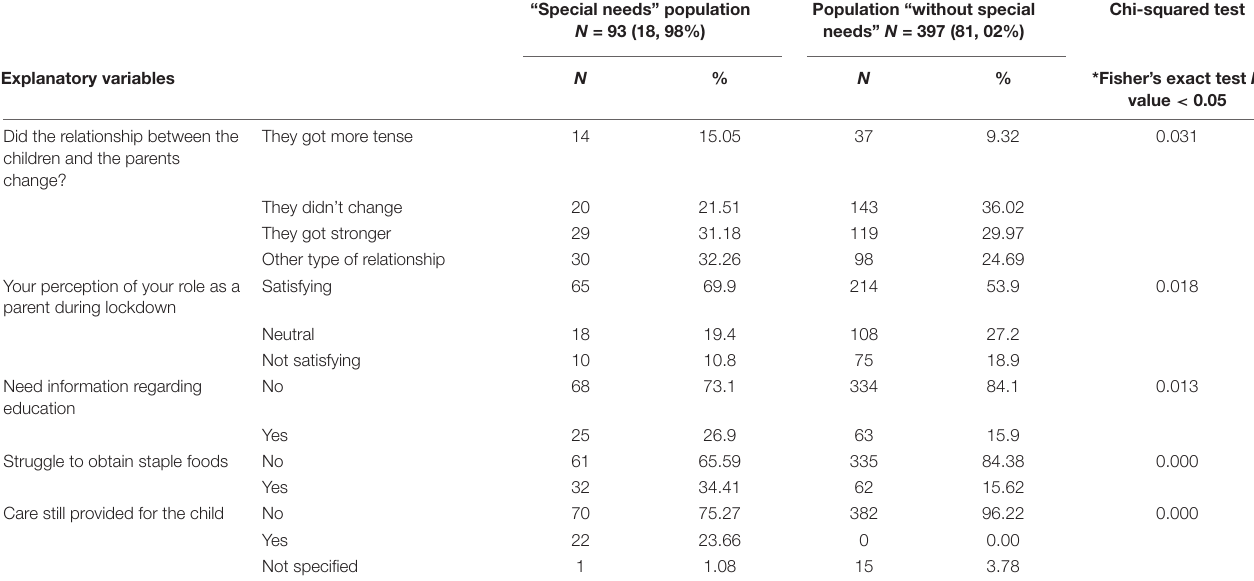
( Table 3A ). Those relationships got more tense for close to a quarter of the families [25.8 vs. 23.9%, χ 2 (2) p = 0.021]. However, for 21.51% of parents from a household with a child with (neuro)developmental impairments, the relationship between partners got stronger, compared to 10.8% within the control families. Furthermore, relationships between children and parents got stronger for close to a third of families, both with a child with a disorder and within control